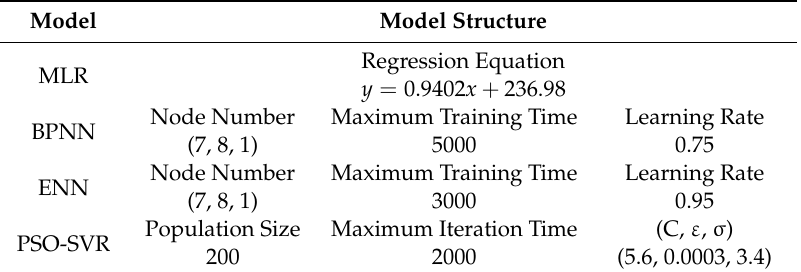
Table 3. Major structures of four forecasting models.